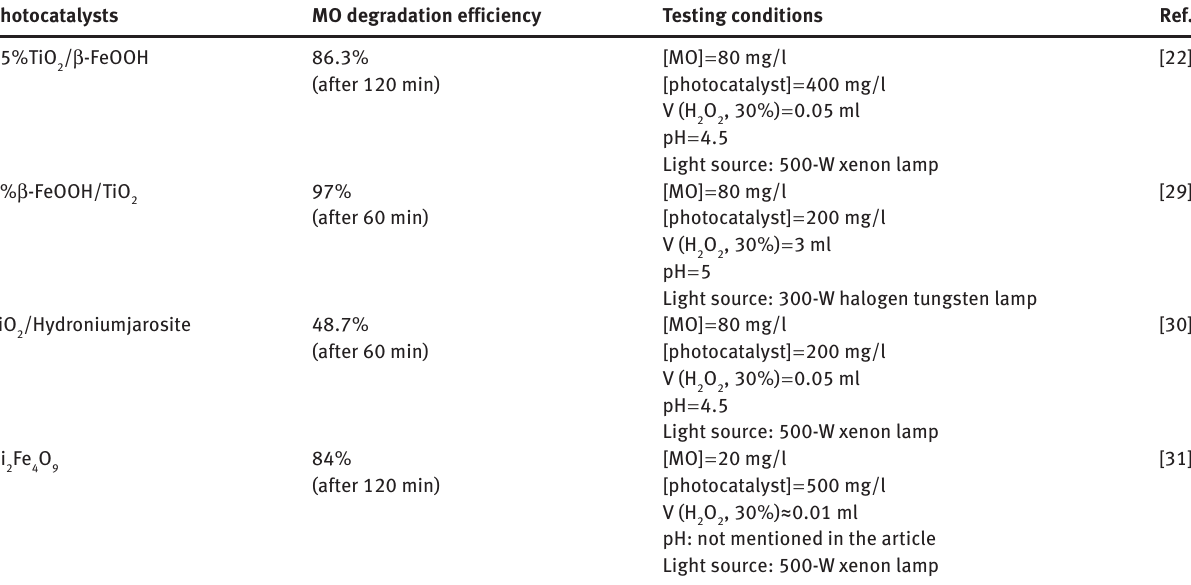
Table 1: Previous studies conducted on the VL catalytic degradation of MO over different Fenton-like catalysts. Photocatalysts MO degradation efficiency Testing conditions